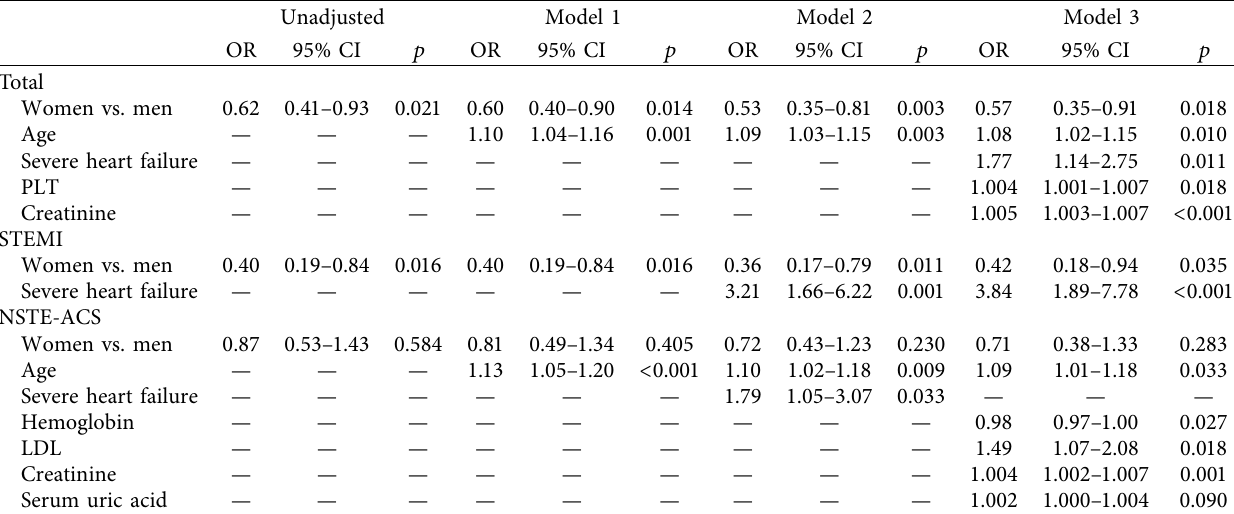
Table 3: Multivariable logistic regression analysis of one-year all-cause